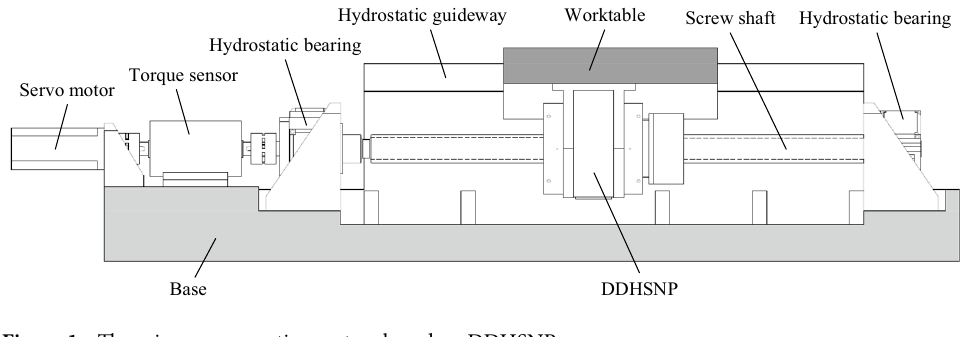
Figure 1. The micro-nano motion system based on